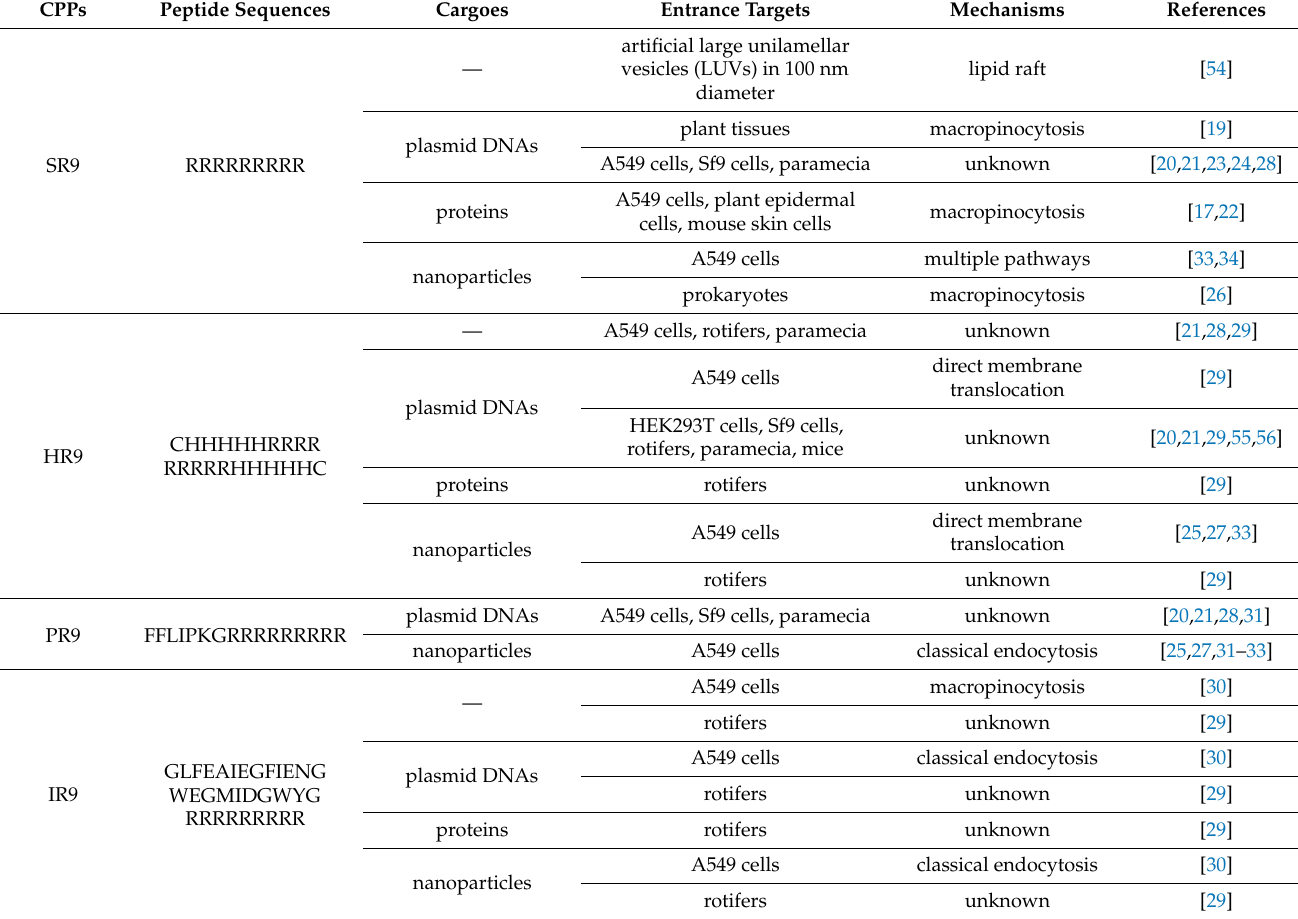
Table 1. Primary sequences of four arginine-rich CPPs and their cellular internalization